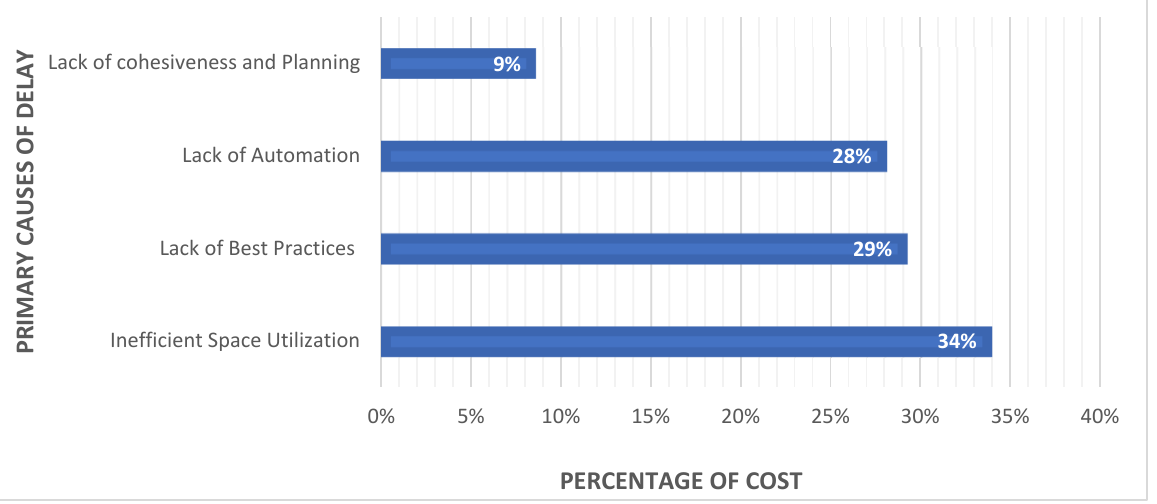
Figure 4. The primary causes of delay in relation to the percentage of cost—narcotic analgesics.